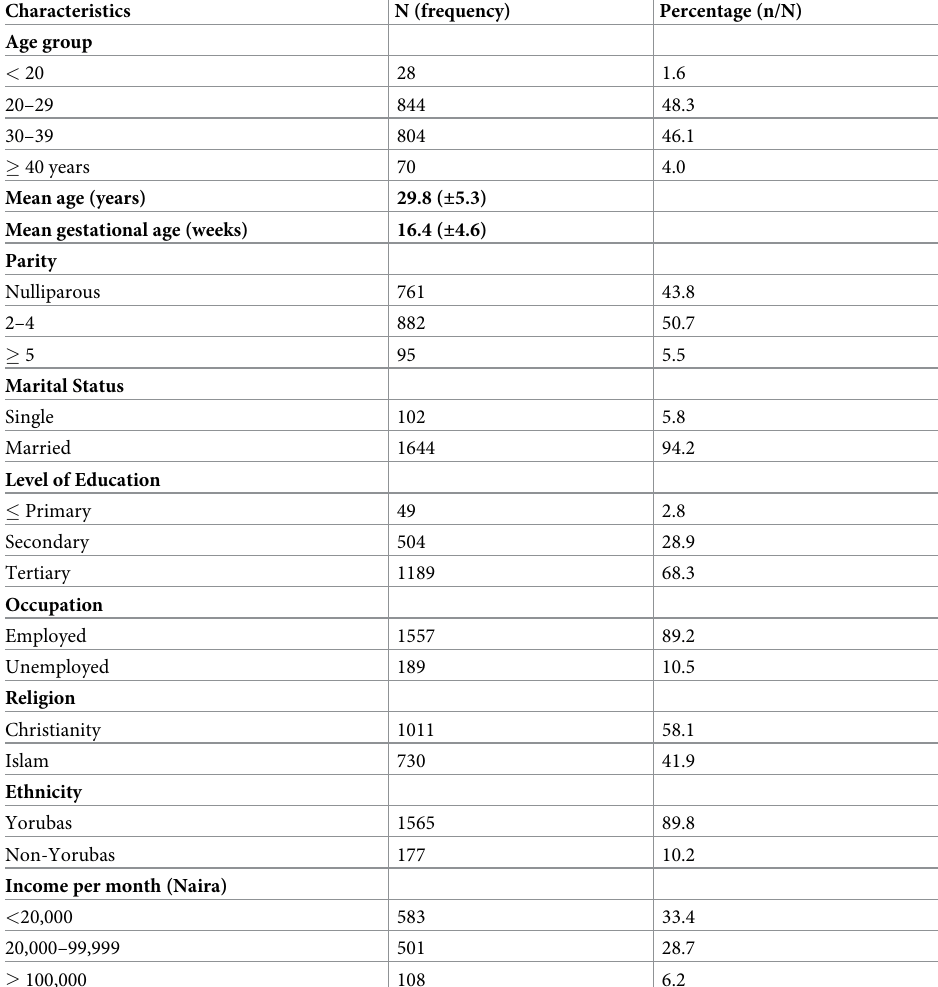
Table 2. Characteristics of the study